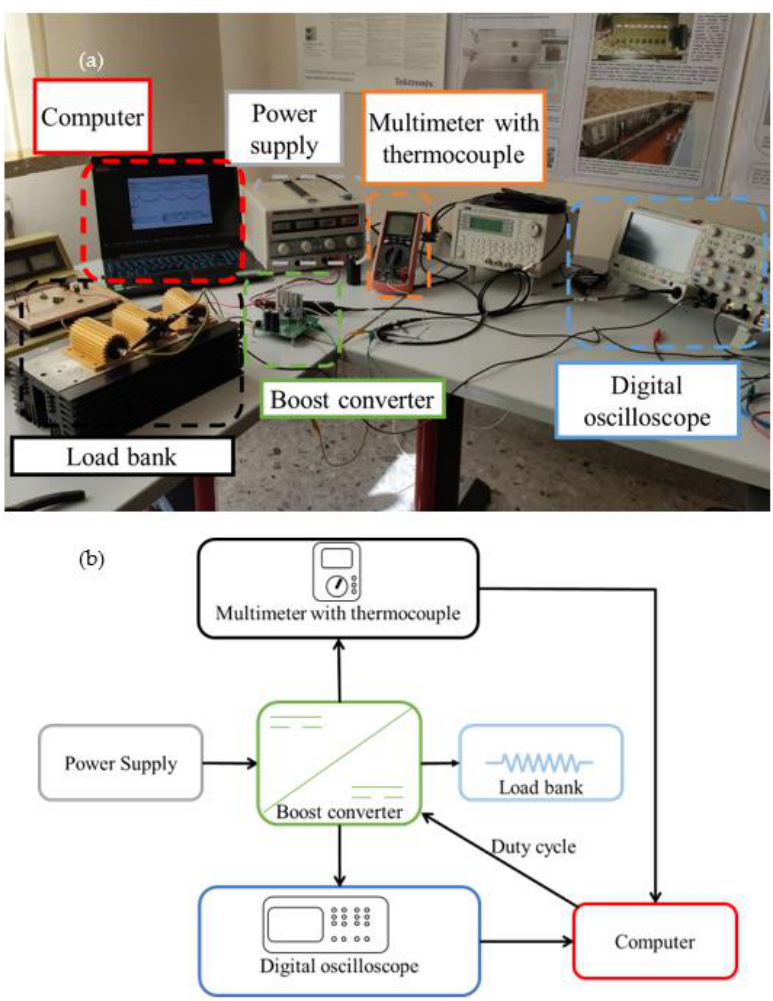
Figure 4. ( a ) Photo of the test rig. ( b ) pictorial diagram of the test rig.